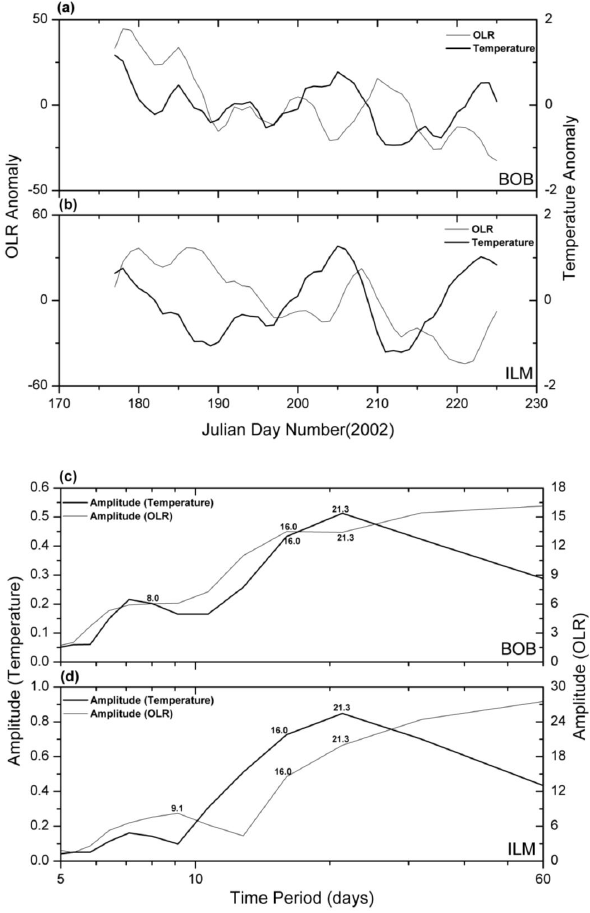
Figure 6. Fig. 6. Time series of OLR and Temperature at 100hPa level ( T 100 ) anomaly for the ARMEX campaign period over (a) Bay of Bengal (BOB) and (b) Indian Land Mass (ILM) regions. Spectrum cor- responding to these time series are shown in panels (c) and (d) ,